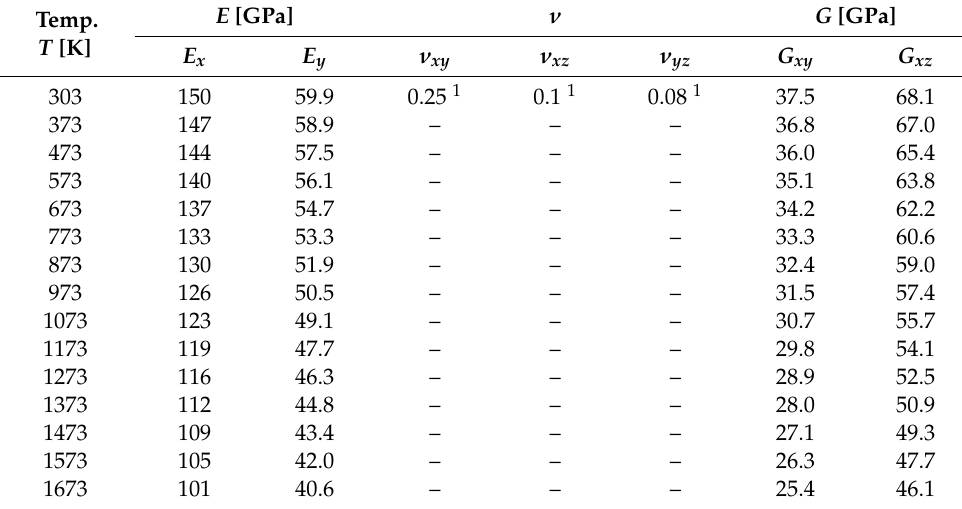
Table 4. Elastic properties ( E , ν , and G ) of SiC / SiC substrate.